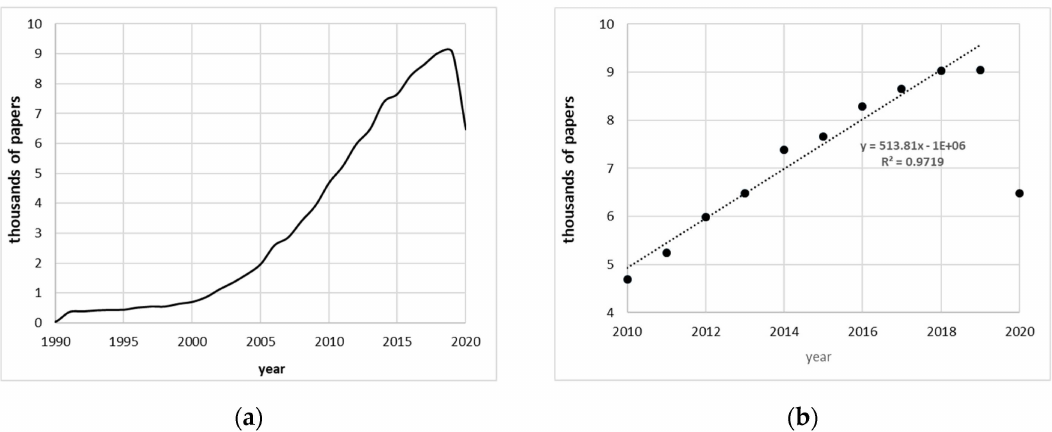
Figure 1. Time evolution of published papers with keyword “ionic liquid” according to Web of Science (updated September 2020) expressed in thousands of papers yearly during ( a ) the last three decades and ( b ) the last